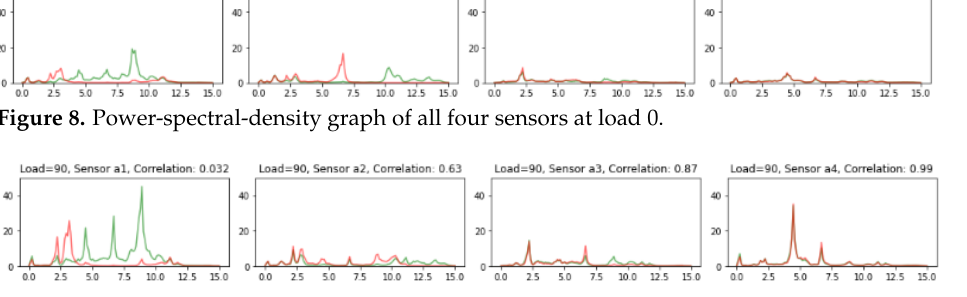
Figure 9. Power-spectral-density graph of all four sensors at load 90.